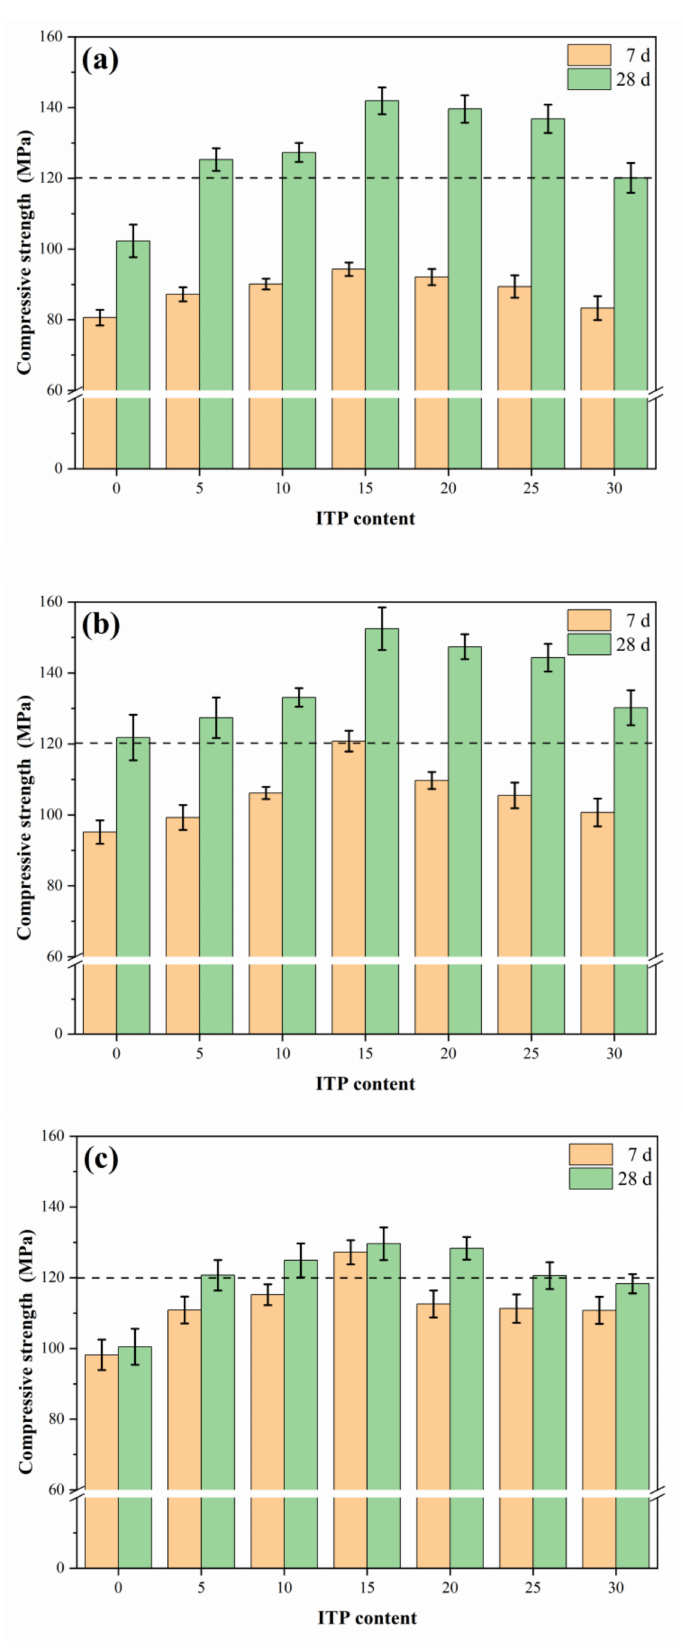
Figure 3. Compressive strength of samples containing ITP under ( a ) standard curing; ( b ) warm-water curing; and ( c ) steam